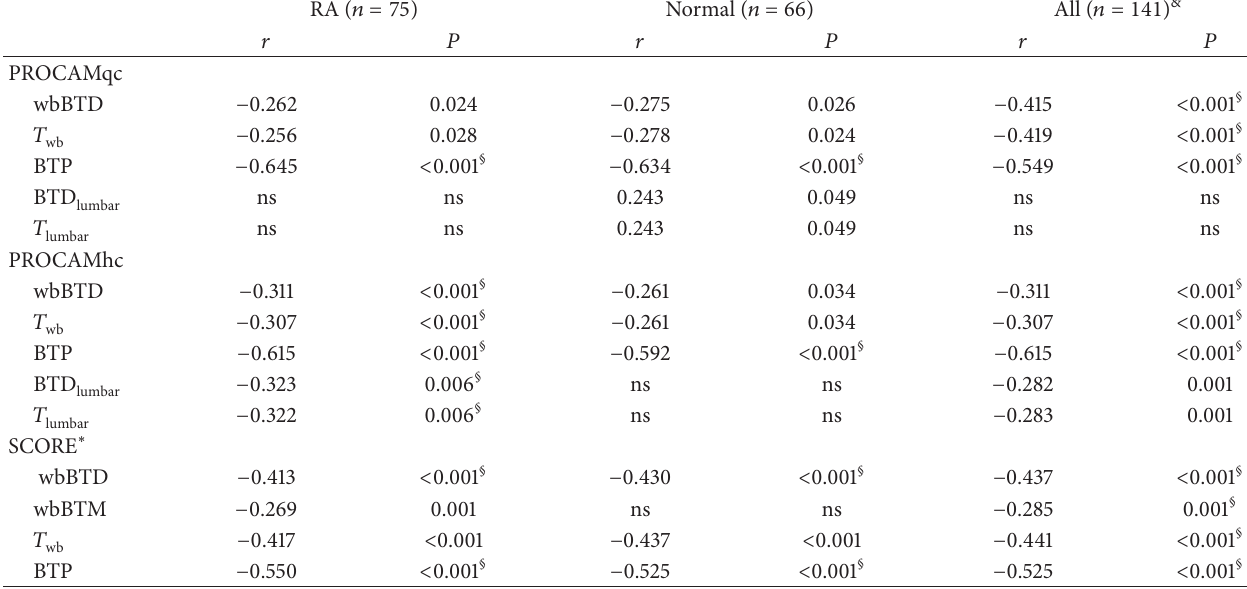
Table 2: Correlation between wbDXA bone indices and estimated CVR.